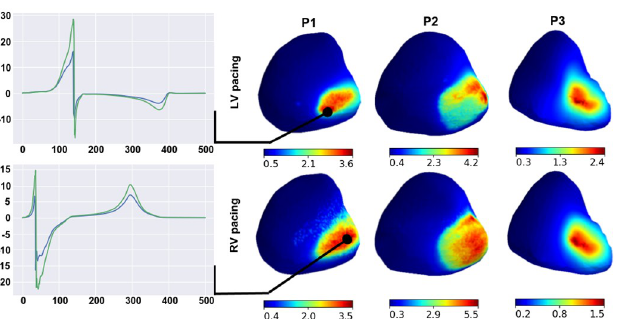
Fig 8. Examples of regional RED maps for extracellular potential signals under variation in the liver conductance. Maps are shown in the right panels for patient models P1–P3 with LV (upper panels) or RV (lower panels) pacing. A color map of every point on the ventricular surface shows the local RED scaling between the minimal and maximal values on the surface (see color scales on the bottom of the maps). Plots on the left show ECG signals from the reference model (green lines) and the model of maximal overall RED (blue lines). The signals are shown for point of the highest local RED on the map.